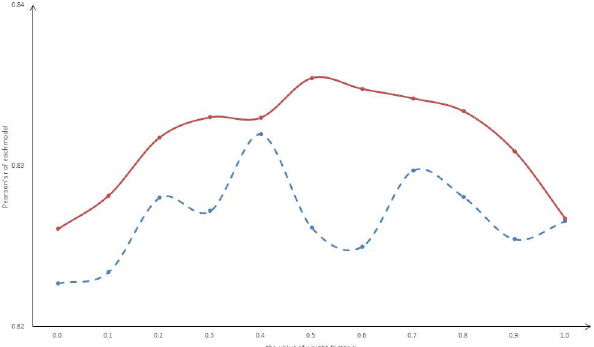
Fig 5. Pearson’s r of D-LSTM with each weight factor. The horizontal axis represents the weight factor, and the vertical axis represents the Pearson’s r. The dotted line indicates the model without pre-training, and the solid line indicates the model with pre-training.